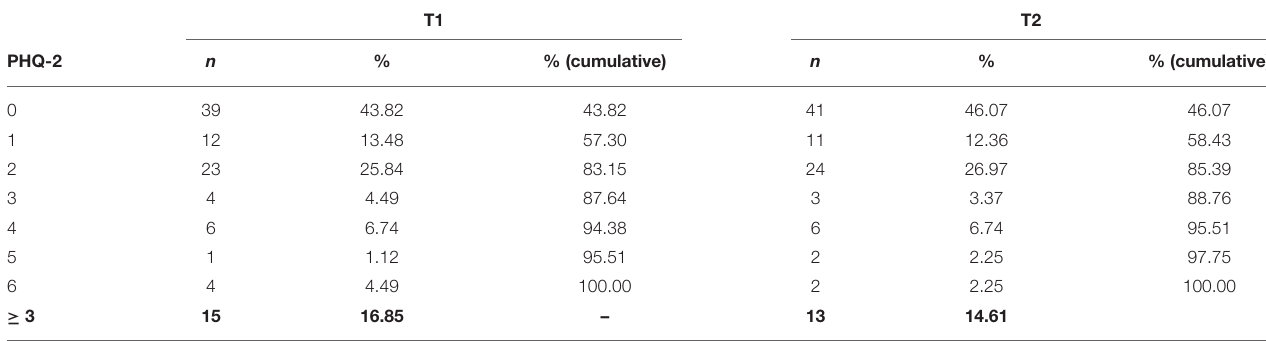
TABLE 2 | Frequency distribution of PHQ-2 sum scores before and during the SARS-CoV-2 pandemic (n total =